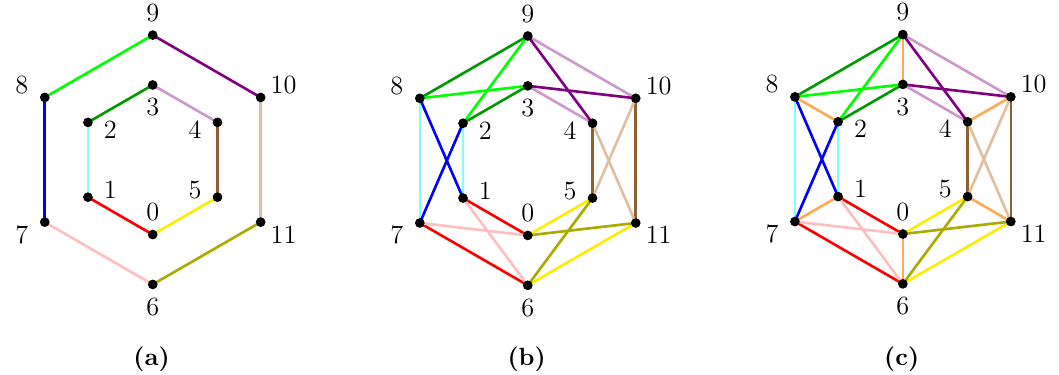
Figure 6. Constructing an interaction vertex with q = 12 and G = Z 2 in three steps. (a) Separate the vertices into two groups of 6, shown here as inner and outer rings. We’ve connected each group only cyclically in order to avoid clutter, but in the full construction, we start with two copies of the complete graph K 6 , one colored according to r ij and the other according to ~ r ij = r ij + q 0 (cid:0) 1. (b) Reconnect the 12 vertices according to the prescription shown in the (cid:12)rst two lines of (4.1). (c) Add the last color according to the third line of (4.1). In the parlance of section 3, these last edges are the internal edges, while the ones colored in the previous step are the external